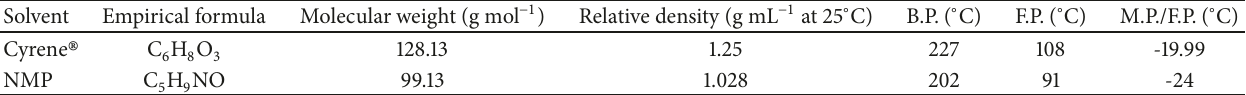
Table 3: Cyrene (cid:2) and NMP safety data